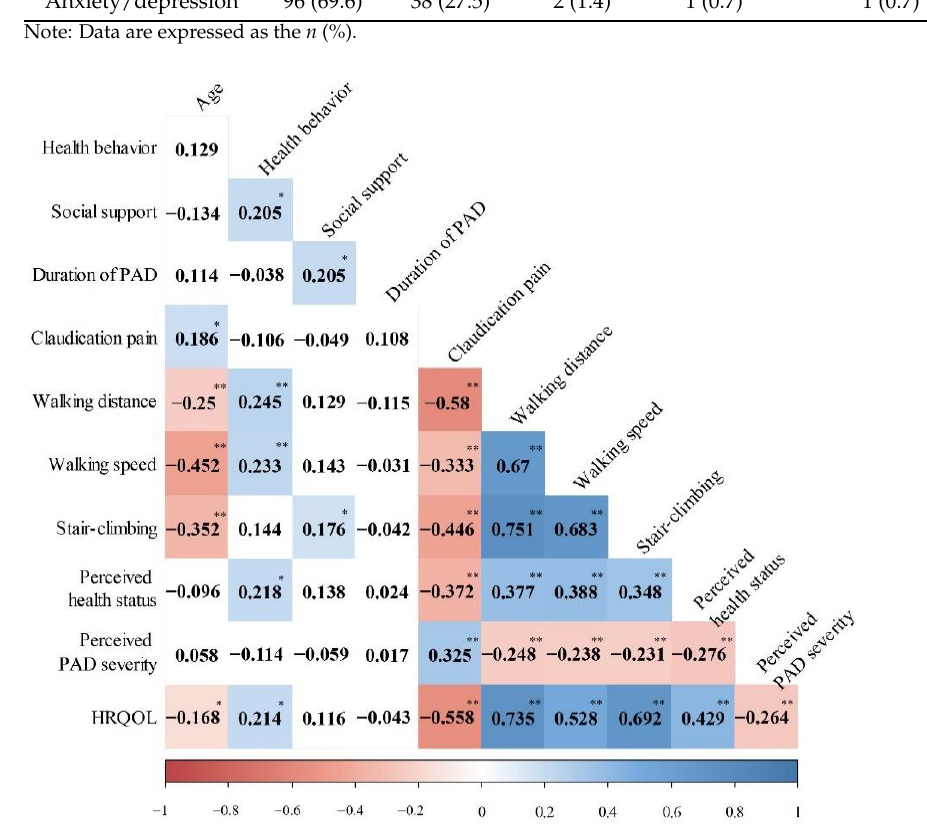
Figure 1. Correlation between influencing factors and HRQOL. Note: HRQOL, health-related quality of life; PAD, peripheral artery disease; * p < 0.05, ** p < 0.001.